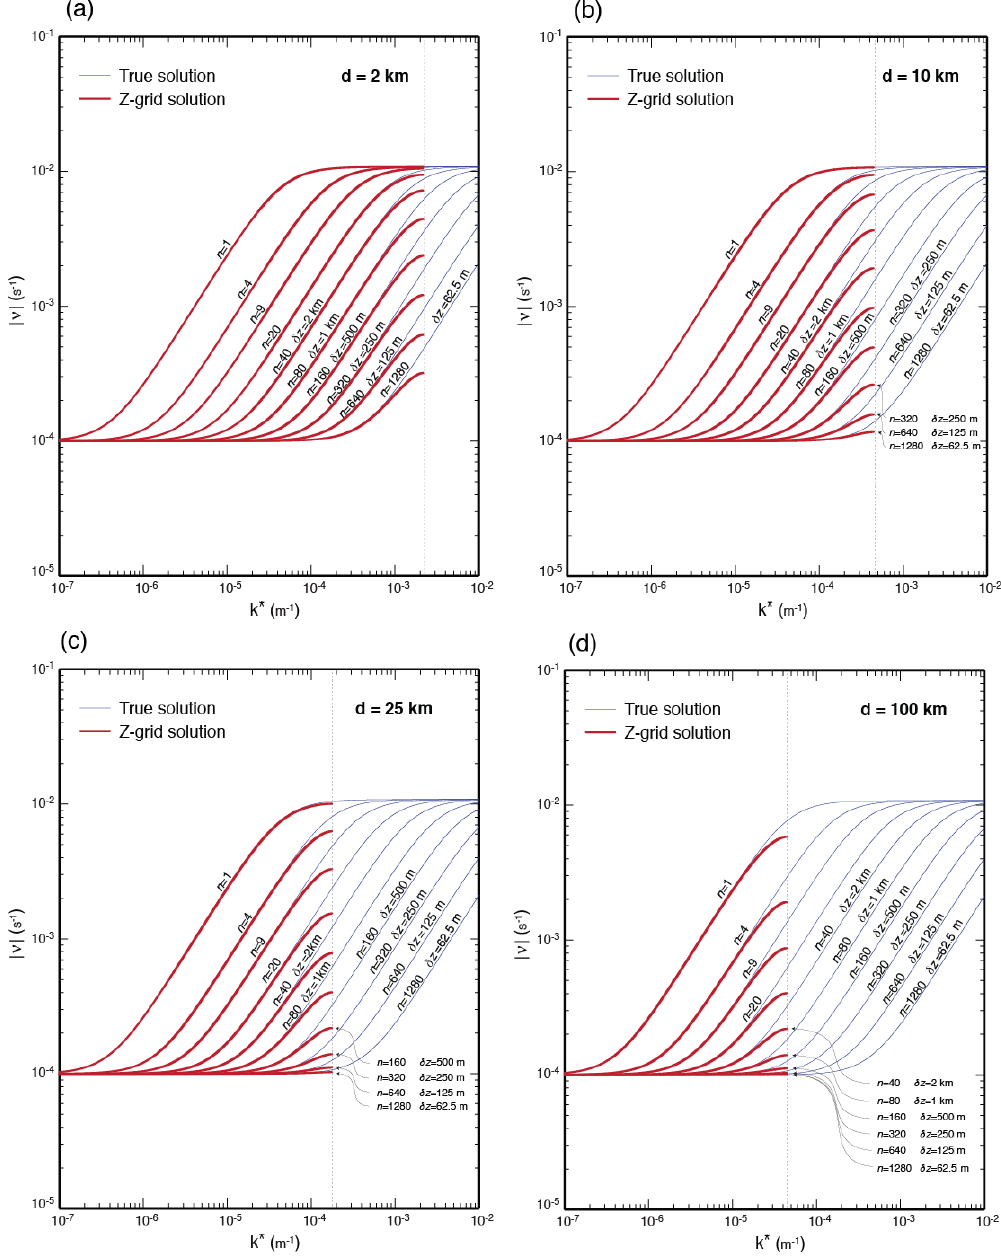
Figure 2. Plots of the absolute value of frequency obtained on the Z grid (red lines) for the grid spacings at (a) 2km, (b) 10km, (c) 25km and (d) 100km, and for the various vertical wavenumbers. The thin blue lines are the corresponding true